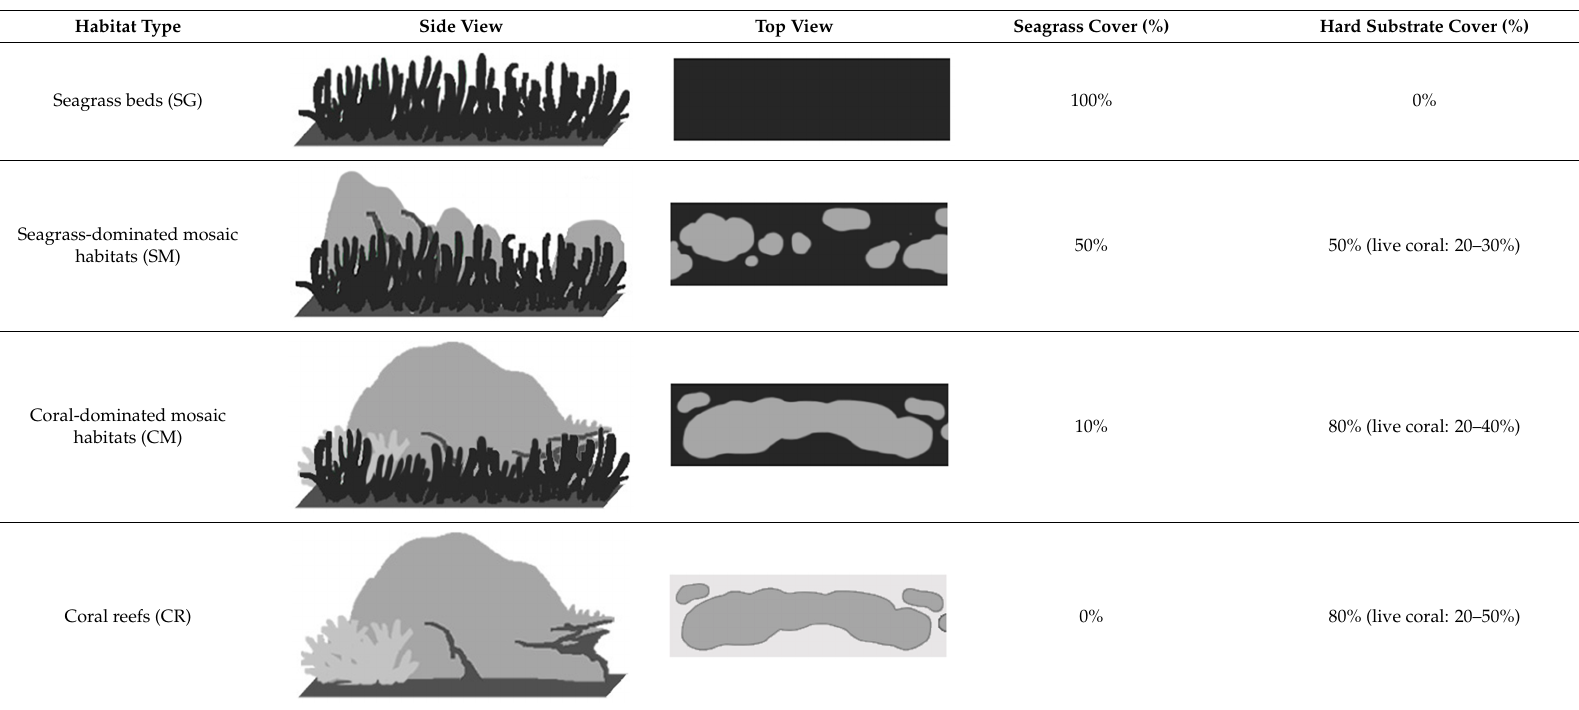
Table 1. A conceptual image of the four habitat types and their characteristics in this study. The dark, grey, and white areas represent seagrass, reef corals, and sand, respectively.